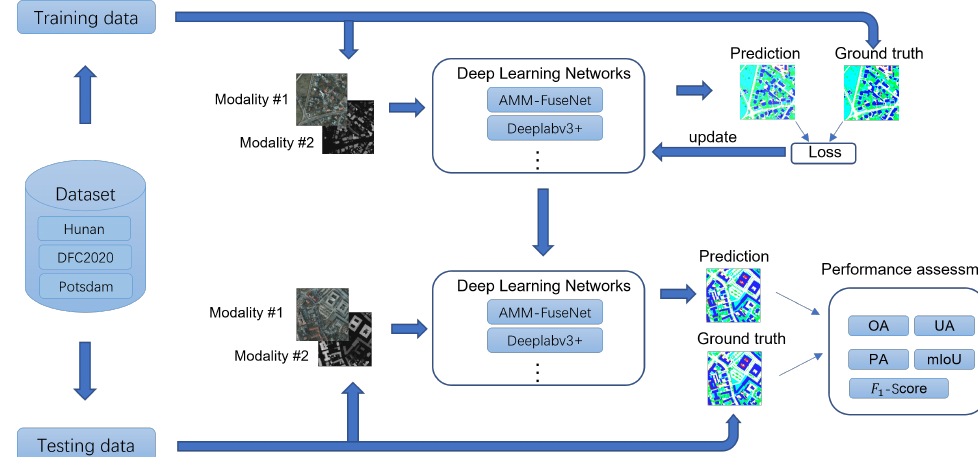
Figure 5. Methodological framework of the land cover mapping application via using deep network architectures. The related assessment metrics in the chart are overall accuracy (OA), user’s accuracy (UA), producer’s accuracy (PA), mean intersection over union (mIoU), and